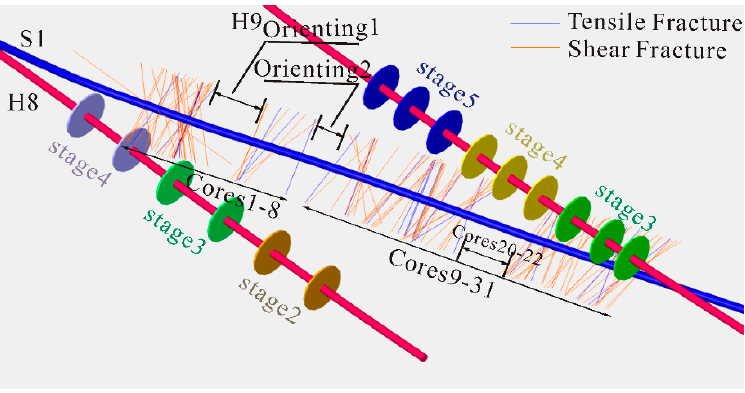
Figure 15. Perspective view of fractures in cores 1-31 from the